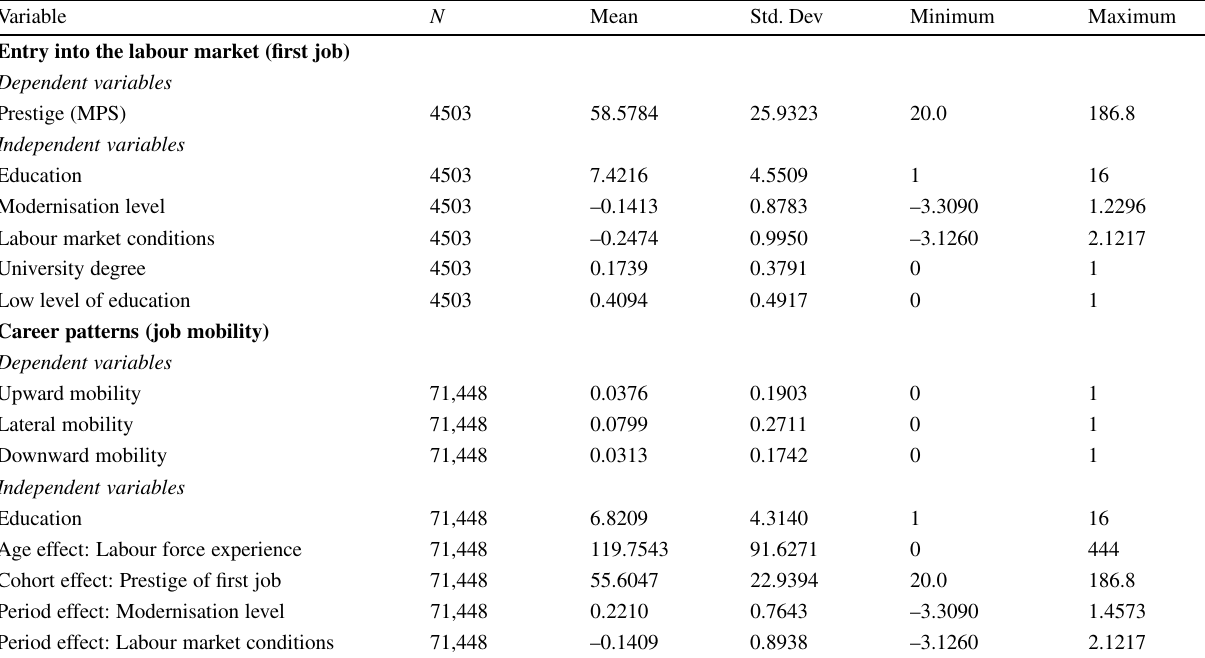
Table 5 Summary of independent and dependent